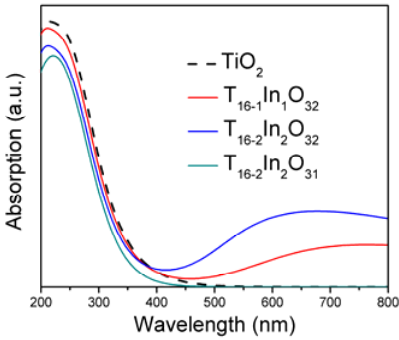
Figure 4. Optical response of the TiO 2 and defect induced TiO 2 models.